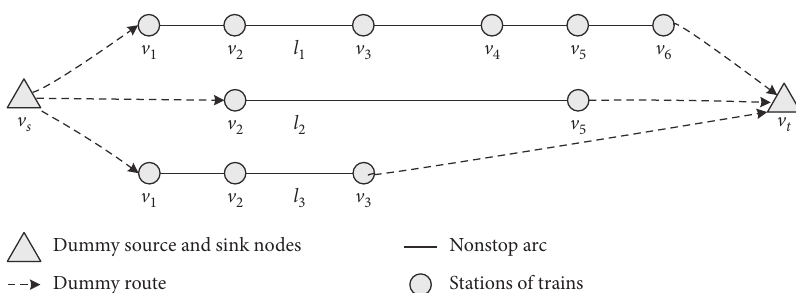
Figure 3: A small example for transforming multiple train ODs into one train